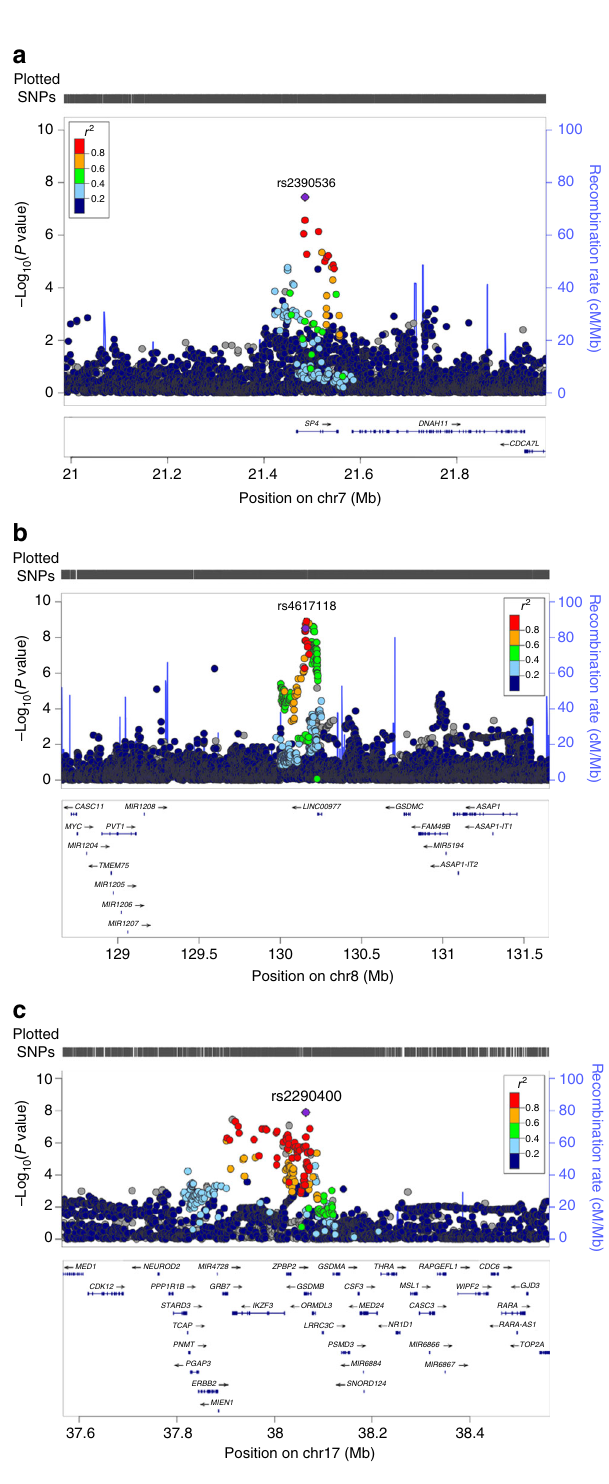
Fig. 2 Genetic association peaks at chromosomes a 7, b 8, and c 17. Genotypes include both “ on array ” SNPs and additional SNPs imputed as described in the Methods. The top associated “ on array ” SNP from the CCRLP/Kaiser discovery analysis is indicated by its “ rs ” identity (and purple diamond shape), and other SNPs are displayed by color showing their extent of genetic linkage with this top SNP. Recombination rate, genetic position, and the locations of nearby genes are indicated. The P values for the association at chromosome 7p15.3 (rs2390536, near SP4 , OR =